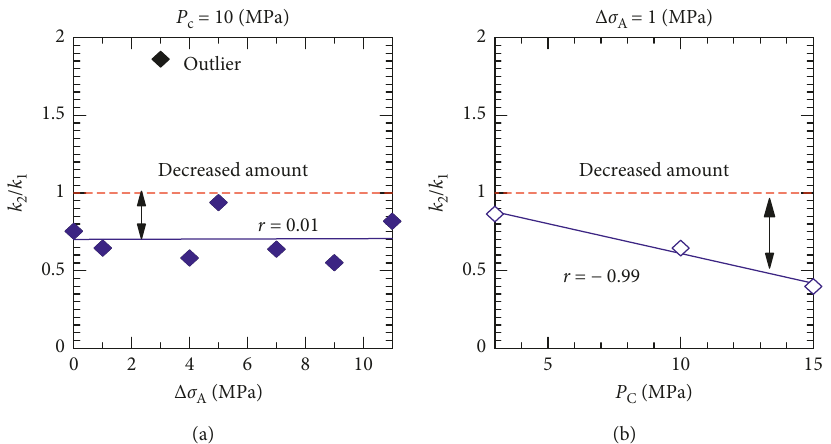
Figure 8: Permeability ratio vs. (a) axial stress disturbance amplitude and (b) confining pressure of the intact rocks. The outlier data point was ignored for the regression analysis.